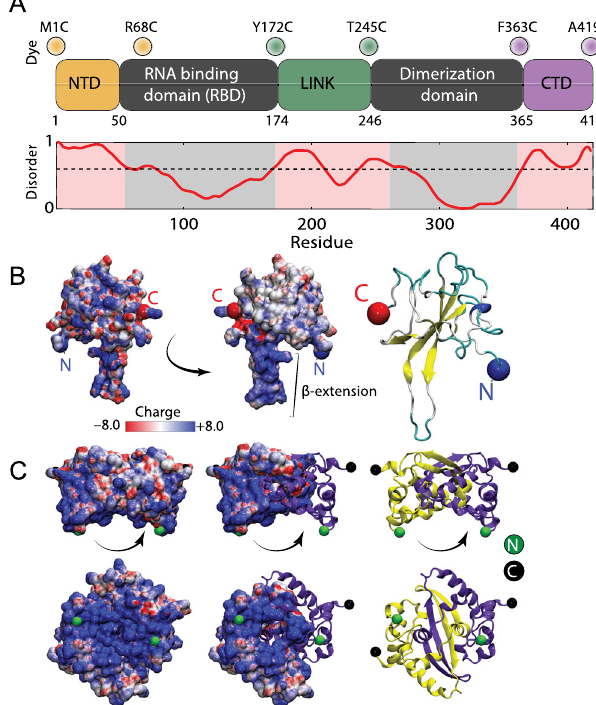
Fig. 1 Sequence and structural summary of N protein. A Domain architecture of the SARS-CoV-2 N protein with disorder prediction performed using IUPred2A 142 . Dye positions used in this study are annotated across the top, disorder prediction calculated across the bottom. The speci fi c positions were selected such that fl uorophores are suf fi ciently close to be in the dynamic range of FRET measurements. Labeling was achieved using cysteine mutations and thiol-maleimide chemistry. B Structure of the SARS-CoV-2 RNA-binding domain (RBD) (PDB: 6yi3). Center and left: colored based on surface potential calculated with the Adaptive Poisson Boltzmann Method 143 , revealing the highly basic surface of the RBD. Right: ribbon structure with N- and C-termini highlighted. C Dimer structure of the SARS-CoV-2 dimerization domain (PDB: 6yun). Center and left: colored based on surface potential, revealing the highly basic surface. Right: ribbon structure with N- and C-termini